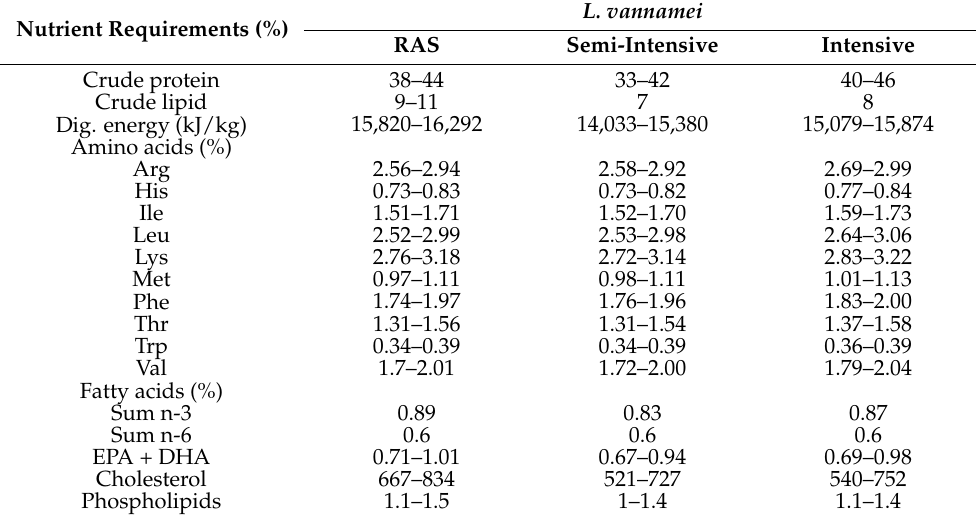
Table 5. Comparison of recommended minimum nutrient requirements in diets for L. vannamei in different production